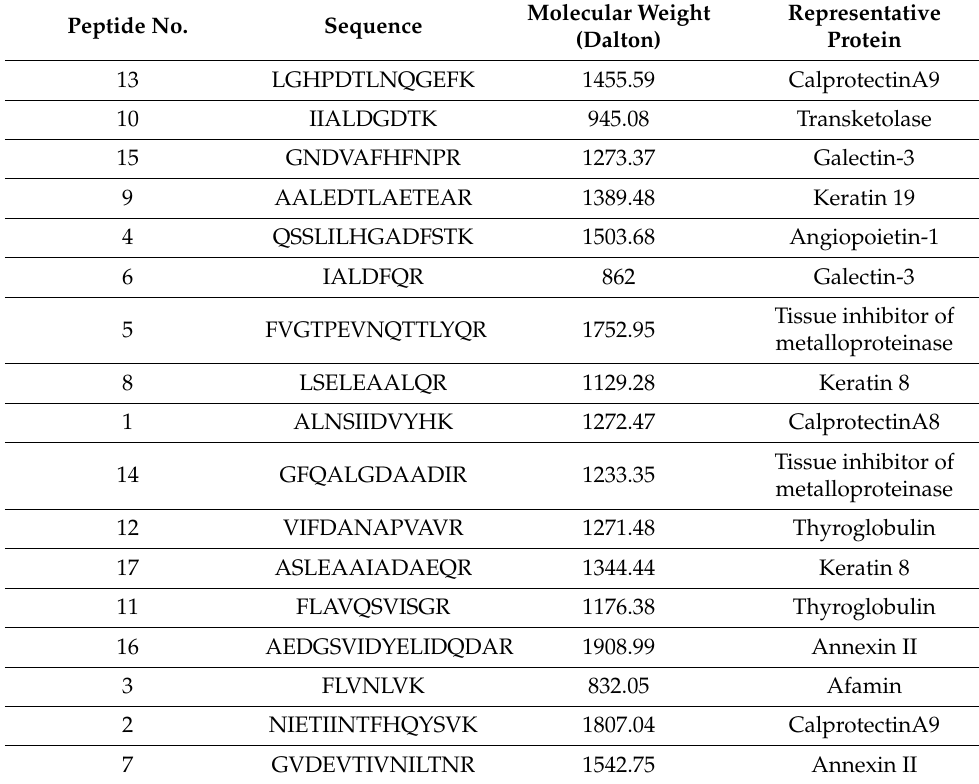
Table 3. Peptide Standards List and Representative Protein (candidate peptide